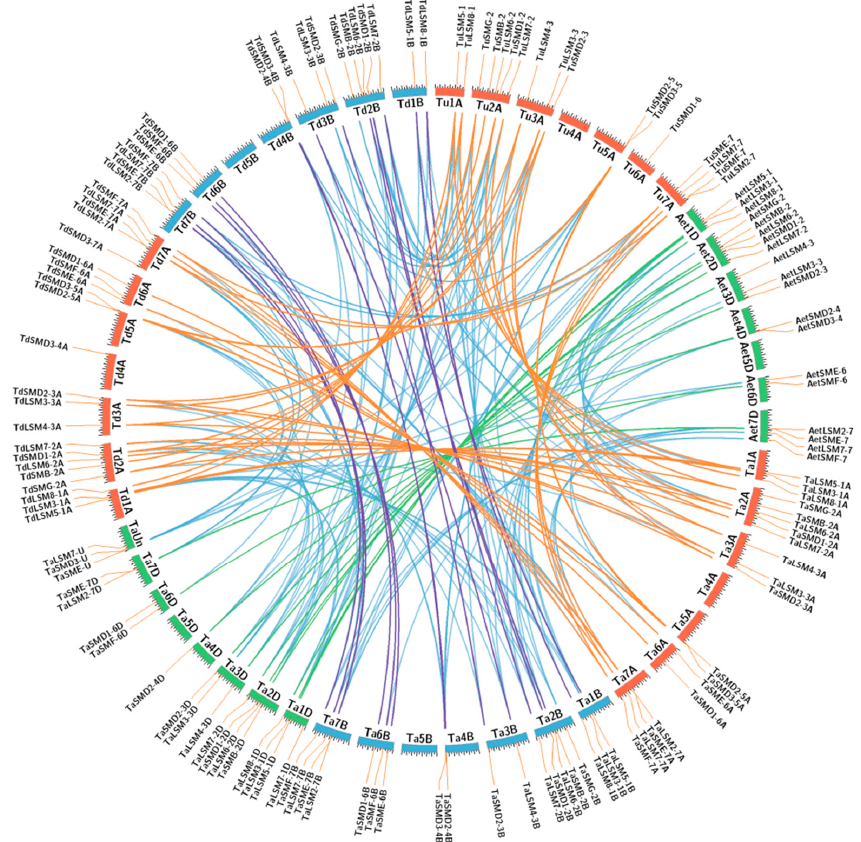
Figure 1. The chromosomal distribution and collinearity analysis of SSM/SLSM genes among bread wheat and relatives. The three subgenomes of bread wheat and its relatives chromosomes are represented by different colors. The SSM/SLSM genes are labeled according to their positions on the chromosomes. The A subgenome chromosome is shown in red, and homeoalleles of the SSM/SLSM gene links are shown in orange. The B subgenome chromosome is shown in blue, and homeoalleles of the SSM/SLSM gene links are shown in purple. The D subgenome chromosome is shown in green, and homeoalleles of the SSM/SLSM gene links are shown in green. Homeoalleles of the SSM/SLSM gene are linked by lines in blue, which represents the correspondence between different subgenomes.